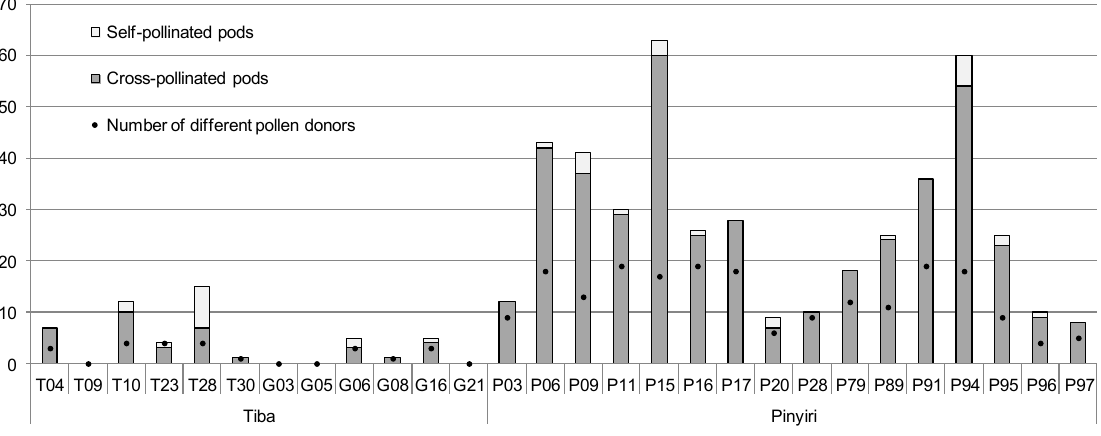
F IGURE 1. Number of genotyped self- and cross-pollinated pods across treatments in Parkia biglobosa shown per tree and site. The points show the total number of dissimilar pollen donors (one father-tree counts only once) across treatments per